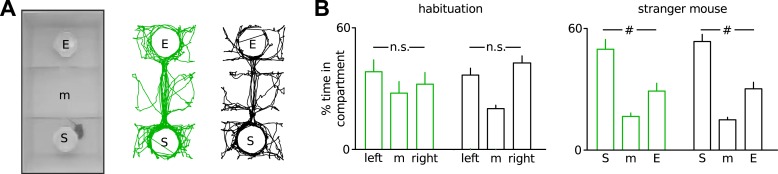
Unaltered sociability of Disc1 mice.(A) 3-chamber social interaction task. The mice explored the 3-chamber arena containing two empty (E) wire cups in a habituation run. In a second run, a stranger mouse (S) was placed in one of the cups (n = 9 each group). Right, examples of exploration paths. (B) Disc1 and control mice spent identical time in both compartments during habituation and more time with the stranger mouse in run two, indicating absent left-right preference and intact sociability, respectively. #p < 0.001. Data are mean ± SEM.